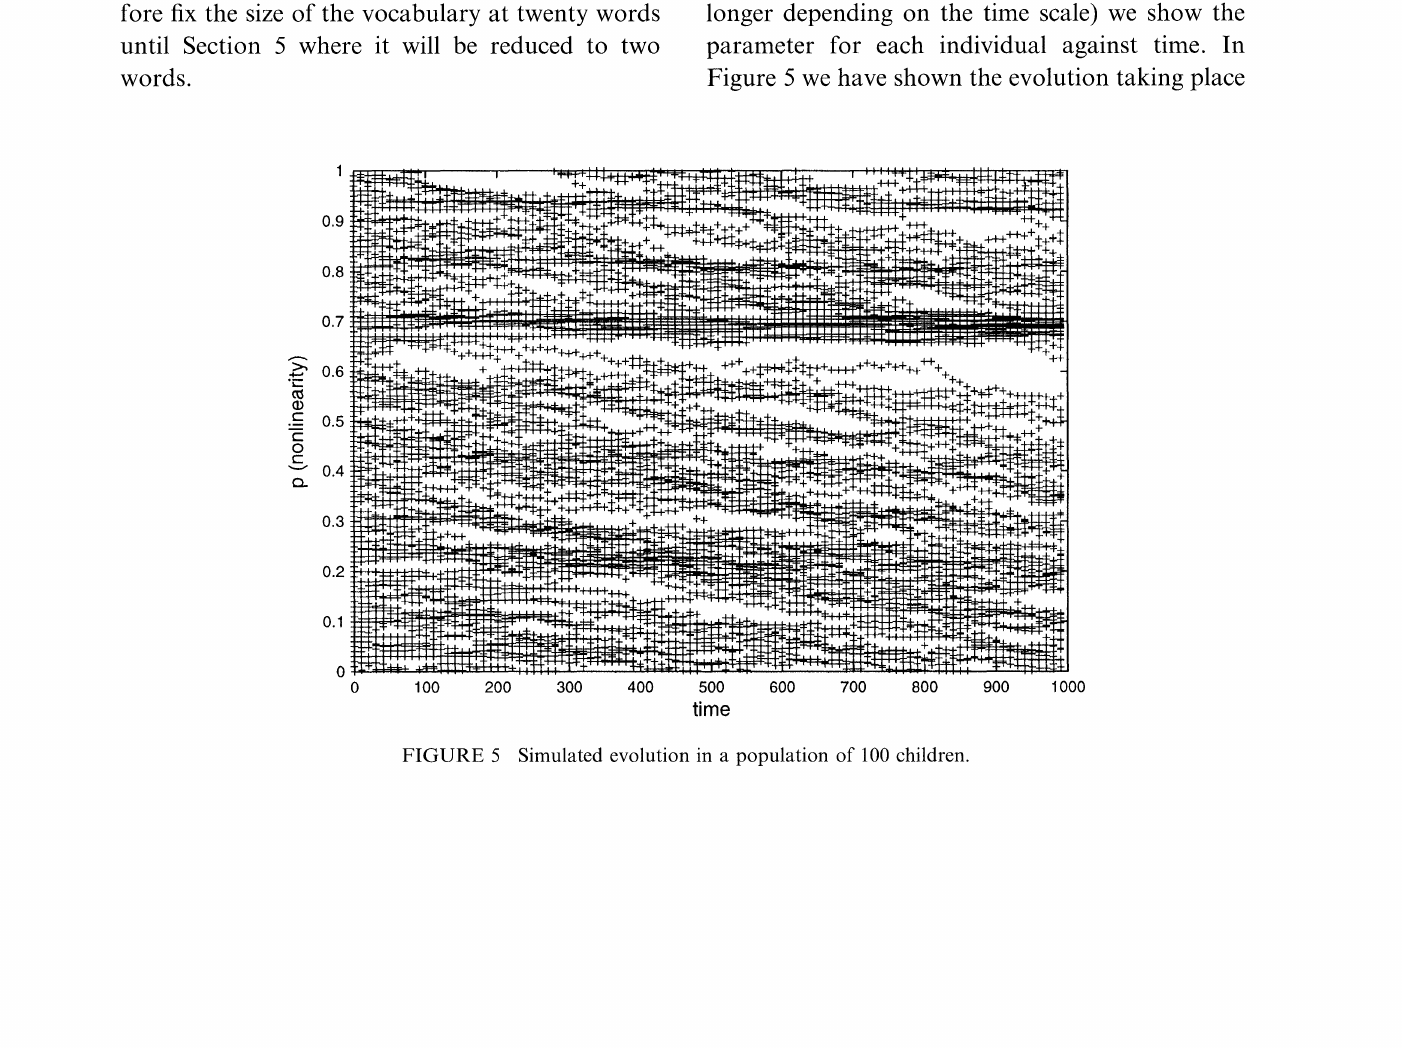
FIGURE 5 Simulated evolution in a population of 100